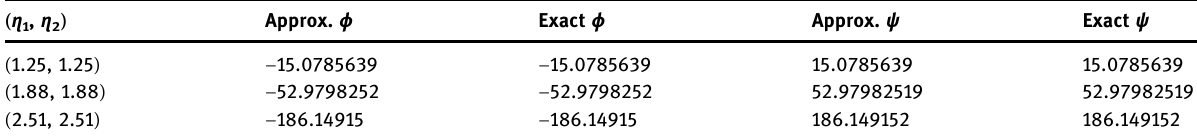
Table 9: Comparison of approximate and exact results at di ff erent mesh points regarding Example 4